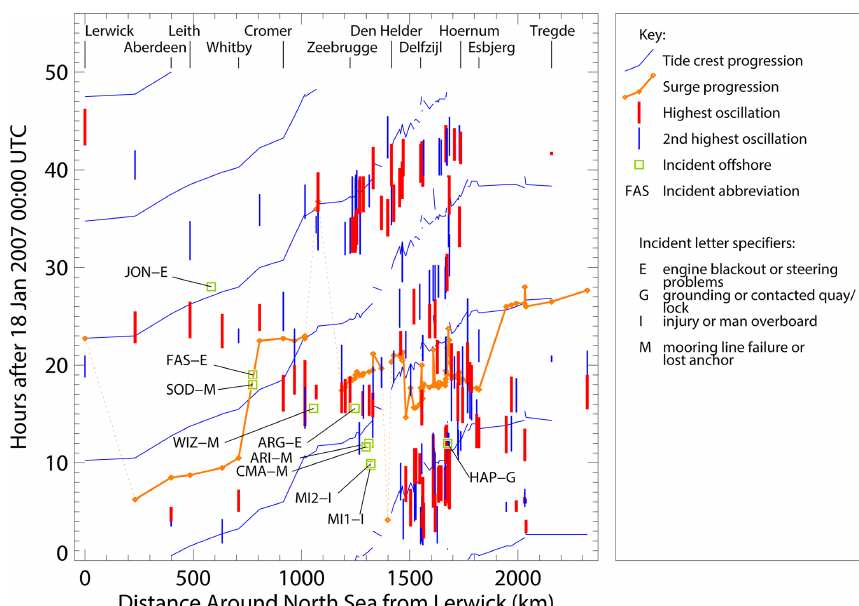
Figure 9. Summary of the progression of the tidal crests and storm surge peak around the North Sea on 18–19 January 2007, and spatial- temporal relationship of peak-to-trough range of the highest up-crossing short period oscillations in the tide gauge record and maritime incidents/accidents. The data are plotted on axes of time versus counter-clockwise distance around the North Sea starting from Lerwick in